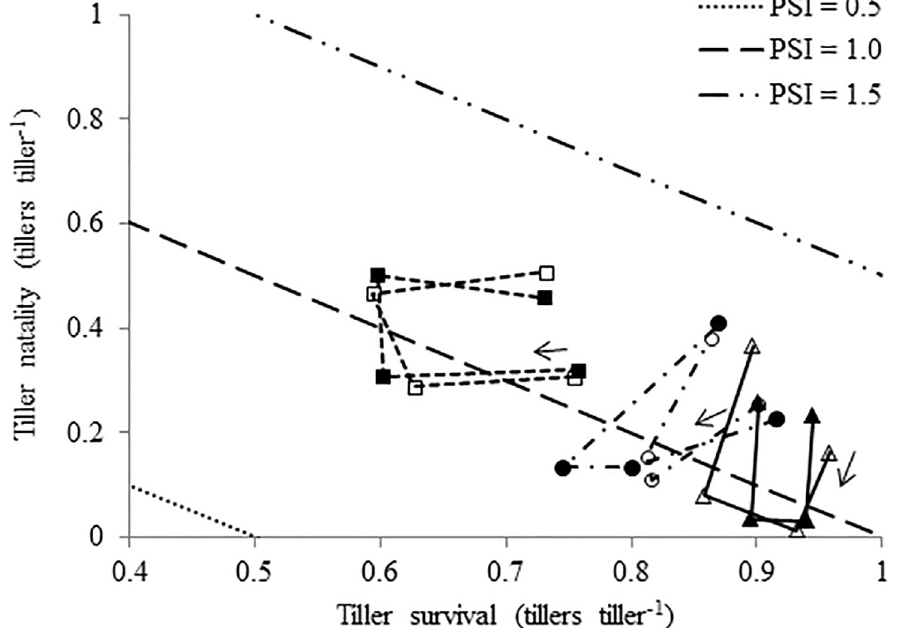
Fig 3. Population stability diagram for Arrhenatherum elatius (squares), Festuca arundinacea (triangles), and Dactylis glomerata (circles) populations sowed as a monoculture (full symbols) or as a mixture (empty symbols) throughout different seasons. The symbols indicate the population stability index (P 1 /P 0 ) resulting from the combination of its tiller survival and tiller natality according to the following equation: P 1 /P 0 = ( b + s )t 1 -t 0 (adapted from Matthew and Sackville Hamilton, 2011). Arrows indicate the sequence of seasons from winter to